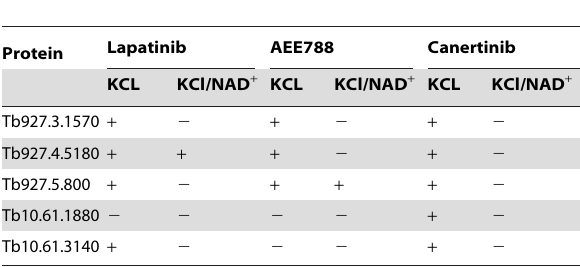
Table 4. An NAD + wash of affinity columns alters ligand selection of target